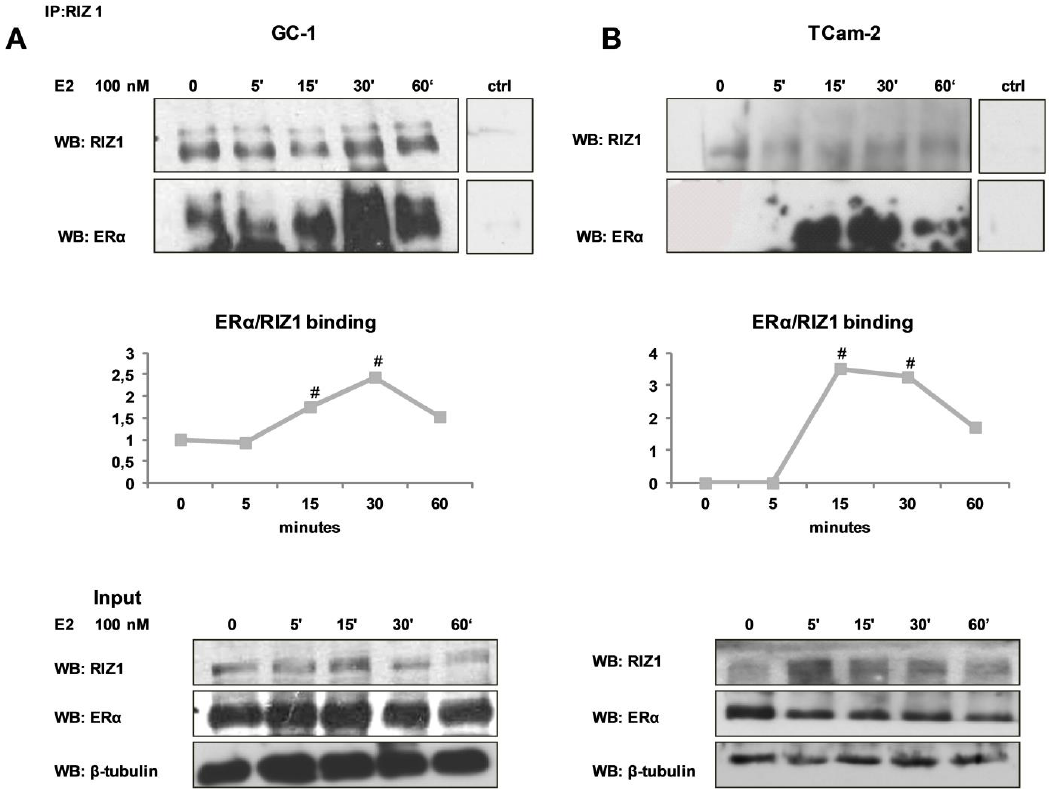
Figure 2. RIZ1/ERα interaction. The interaction between RIZ1 and ERα was evaluated by immunoprecipitation, SDS-PAGE and Western blot analysis of total protein cell extracts from GC-1 and TCam-2 cell lines treated with 100 nM estradiol (E2) for 5, 15, 30 or 60 minutes. Immunoprecipitation was performed with N-20 anti RIZ1 antibody; Western blot was performed with ab9710 anti-RIZ1, anti-ERα or anti-α-tubulin antibodies. An anti-rabbit IgG beads were used in the absence of N-20 anti RIZ1 antibody as a control (ctrl). Input: total protein cell extracts. ER/RIZ1 binding graphs represent the ratio between the value obtained by densitometric analysis of the bands corresponding to ERα and RIZ1 by ImageJ software. The blots are representative of three independent experiments (# indicates p < 0.05). ( A ) GC-1 cell line; ( B ) TCam-2 cell line.